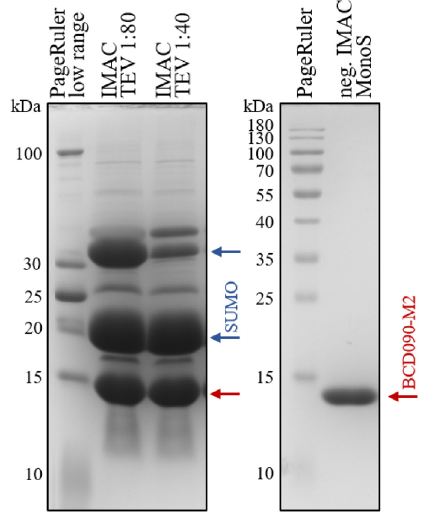
Figure 1. Expression and purification of BCD090-M2 VHH antibody. The antibody was expressed in the cytoplasm of E. coli SHuffle cells as His -SUMO fusion, purified by IMAC and cleaved 6 with TEV protease at 1:80 or 1:40 enzyme:substrate ratio. The bottom band marked with a red arrow corresponds to BCD090-M2, the middle band marked with a blue arrow is a histidine-tagged SUMO, and a top band is an uncleaved protein. After the cleavage, BCD090-M2 was further purified by negative IMAC and cation- exchange chromatography on MonoS, the SDS-PAGE analysis of the purified antibody is presented in the right panel.